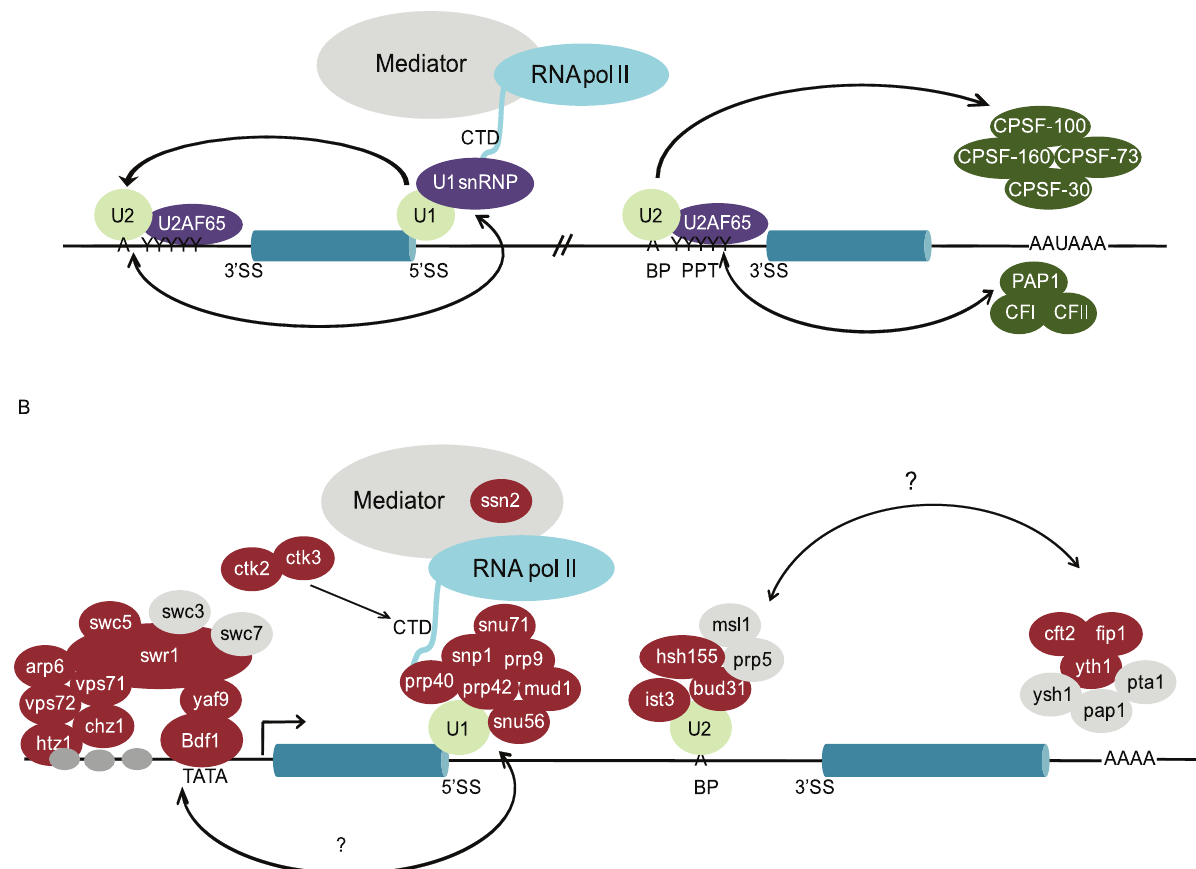
Figure 7. The location of mutants that disrupt splicing suggests a similarity to exon-definition in mammalian splicing. A. Spliceosome assembly in mammalian systems is thought to occur via exon-definition, where interactions between U1 and U2 snRNP components across an internal exon, or CPSF components and U2 snRNP across a terminal exon, are necessary for efficient processing of the upstream intron. B. Functional location of a subset of the mutants examined in this work, presented on a model transcript. Factors shown in red caused a statistically significant increase in the precursor levels of at least one transcript in our screen, whereas those in grey did not affect the splicing of any of the transcripts.